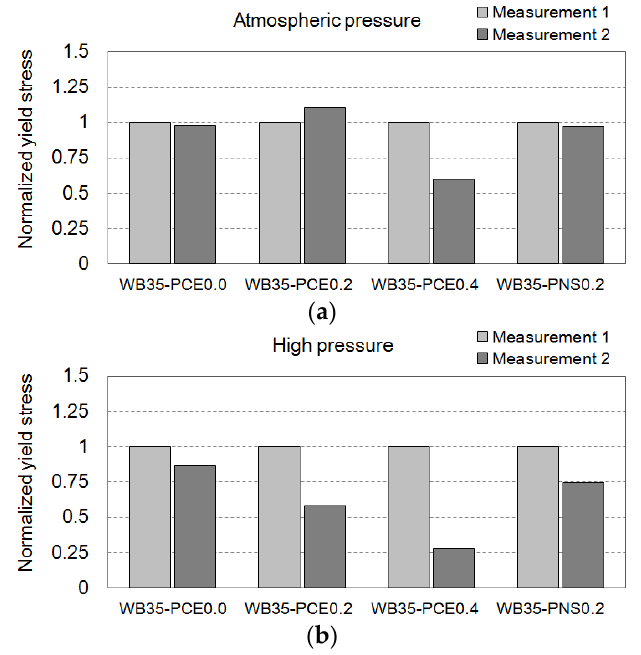
Figure 7. Normalized yield stress of the cement paste with different superplasticizers under ( a ) atmospheric pressure and ( b ) high pressure.